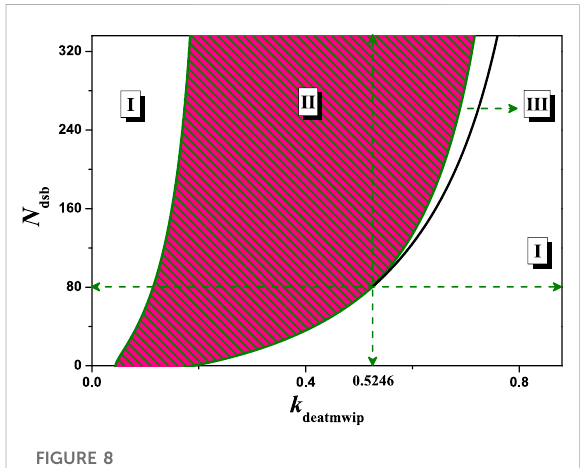
The two-parameter bifurcation with respect to k deatmwip and ‘ I ’ , ‘ II ’ and ‘ III ’ represent monostable state, N dsb . The symbols oscillation state and excited state respectively. The vertical dots line indicates k deatmwip =